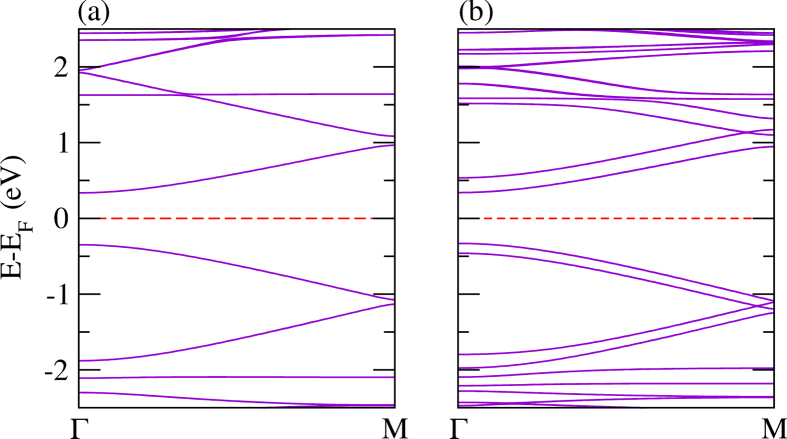
The electronic structure of (a) S-Se-Te1 (b) S-Se-Te2.